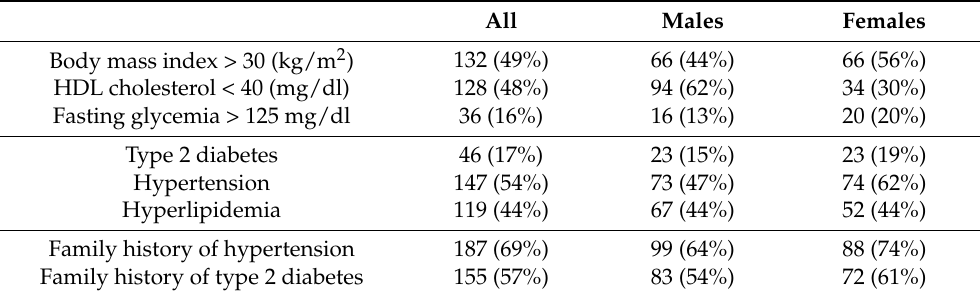
Table 2. Pathophysiological components and risk factors of the cardiometabolic syndrome in individ- uals of the study group. Number of cases is reported and percentages are given in